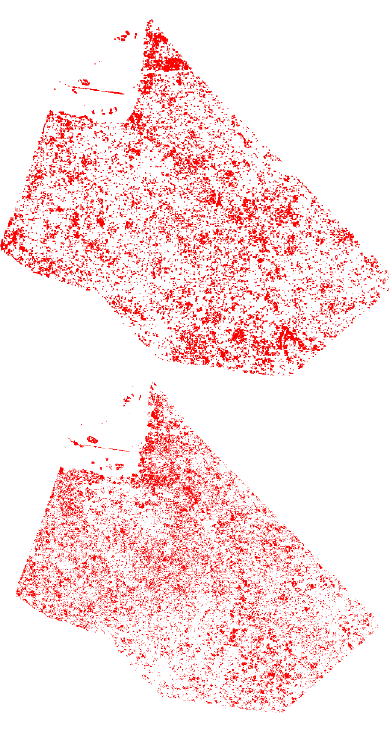
Figure 17: 0.40m resolution voxel plots, where voxels do/do not contain near-surface fuel (above) and elevated fuel (below).